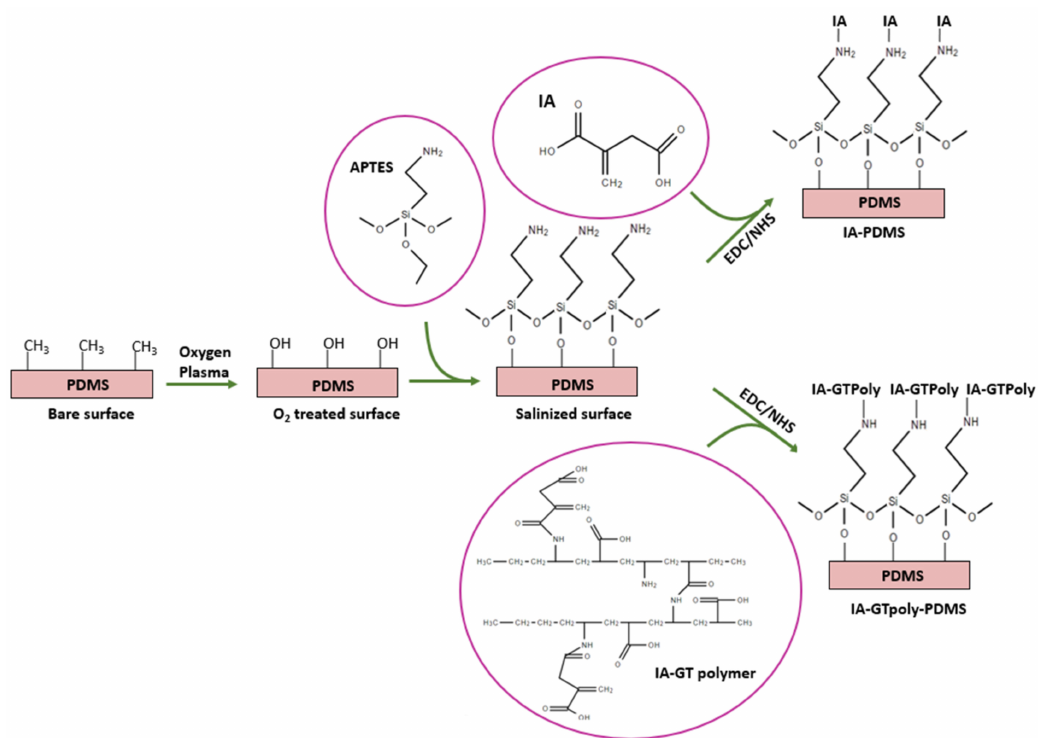
Figure 10. Surface modification of silicone implants with itaconic acids (IA). Gelatin was used to conjugate the IA on the PDMS surface. IA and IA-GT polymer both immobilized on the PDMS surface and evaluated their performance in terms of sustain delivery